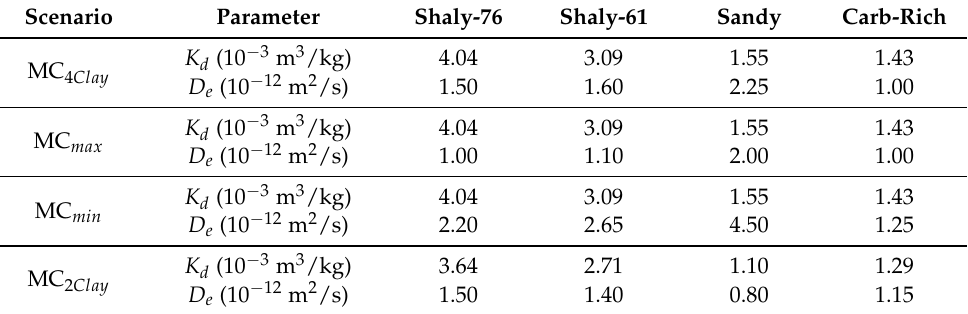
Table 3. Calibrated transport parameters ( K d and D e ) from the different scenarios of the MC diffusion simulations on the metre-scale and after a simulation time of 100years for the facies of the Opalinus Clay.